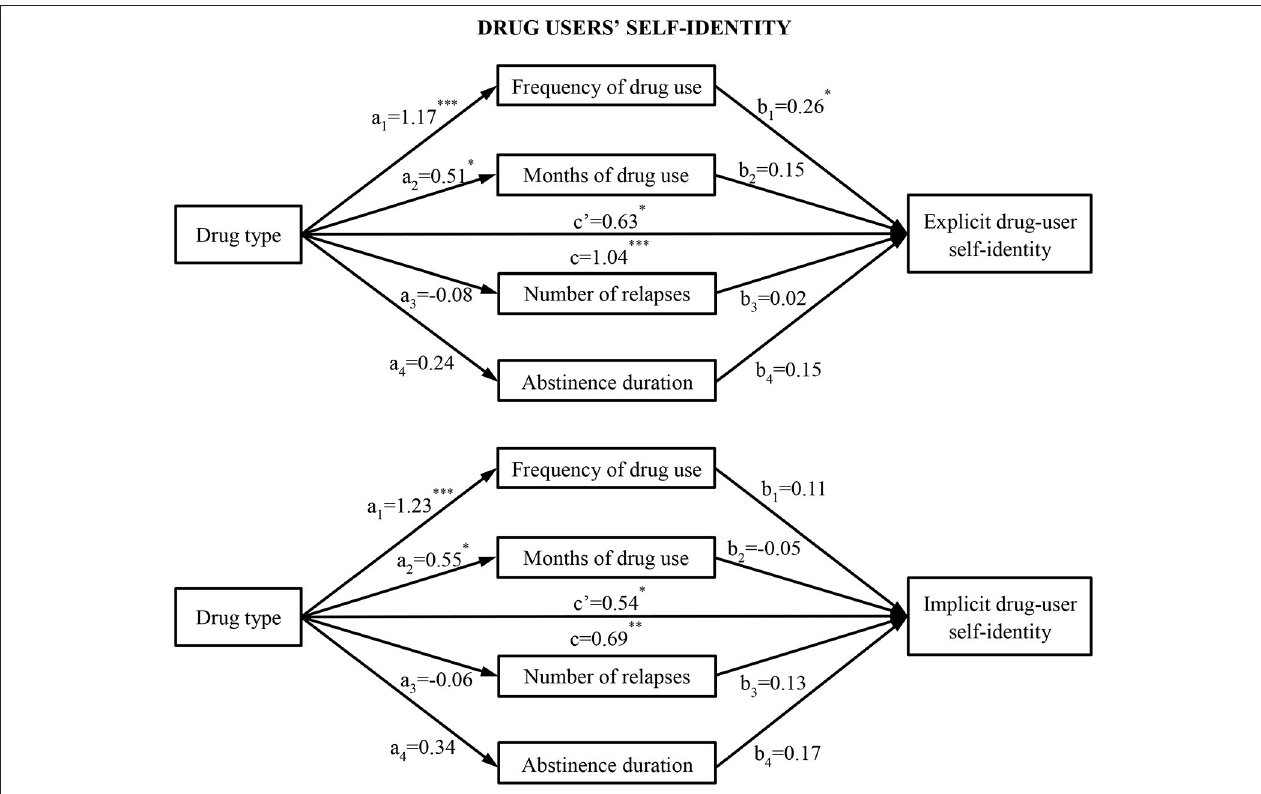
FIGURE 1 | Drug-use behaviors and abstinence duration as mediators between drug type (i.e., heroin and methamphetamine) and implicit and explicit drug-user self-identity. The (c’) value represents the direct effect of the drug type on implicit and explicit drug-user self-identity after the mediators were included. The (c) value represents the effect of the drug type on implicit and explicit self-identity before the inclusion of the mediators. * p < 0.05, ** p < 0.01, *** p < 0.001.